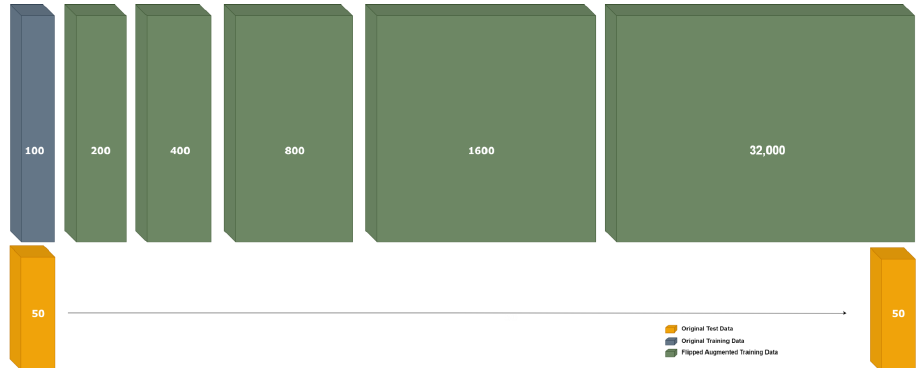
Figure 13. Augmentation by flipping: Original test dataset was kept the same. On the other hand, the training dataset was augmented from 100 graphs up to 32,000 graphs through 5 stages.